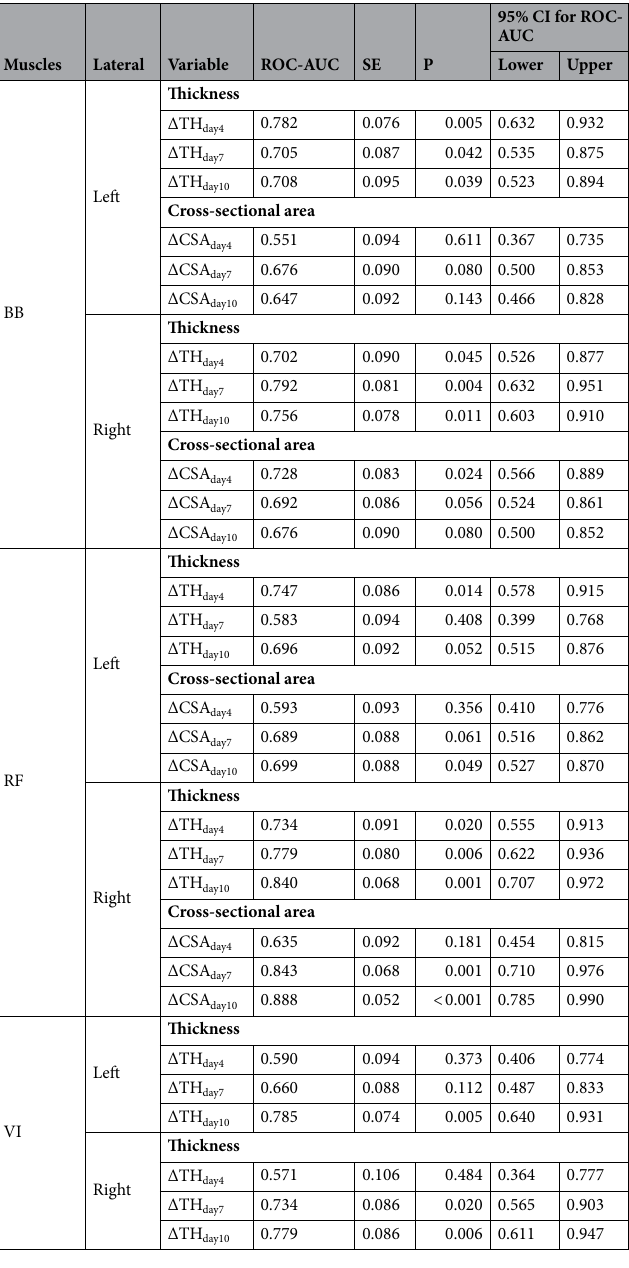
Table 2. Receiver Operating Characteristic curves of changes in thickness and cross-sectional area of muscles over time. BB, biceps brachii; RF, rectus femoris; VI, vastus intermedius; ΔTH, changes in thickness; ΔCSA, changes in cross-sectional area; SE, standard error; ROC-AUC, receiver operating characteristic curves with calculated area under the curve; CI, confidence